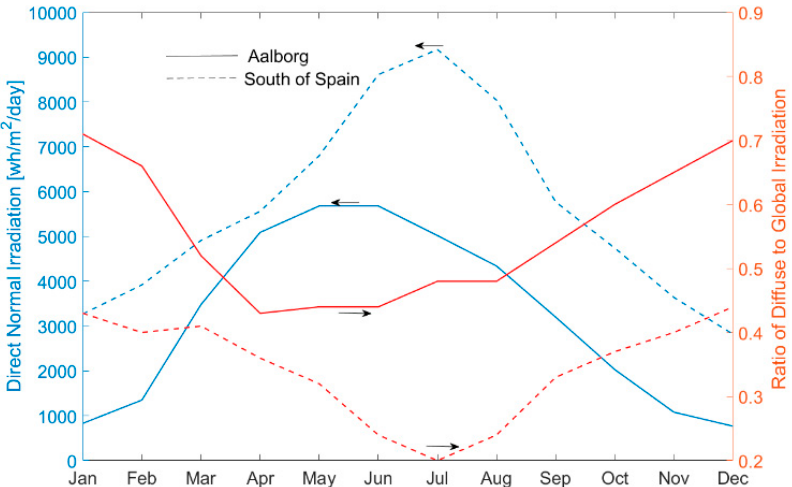
Figure 1. Direct normal irradiation and the ratio between diffused and global irradiation of two different places in Europe with different annual direct irradiance (2046 kWm − 2 year − 1 in Gibraltar and 1157 kWm − 2 year − 1 in Aalborg) [25].